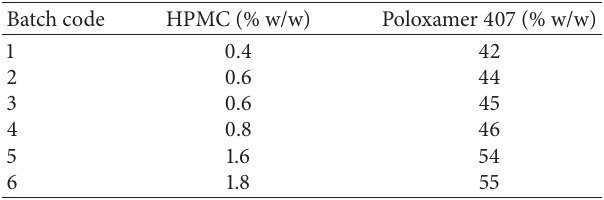
Table 1: Preliminary batches.